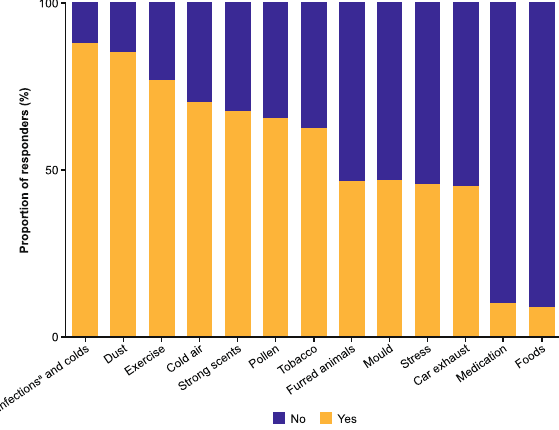
Fig. 2 Common symptom triggers as reported by Ext-SLS participants with asthma at the time of Ext-SLS consent. Ext-SLS extended Salford Lung Study. Note: a Of the airway. Responders providing a “ Yes ” or “ No ” answer n = 589 – 760 variable per question.